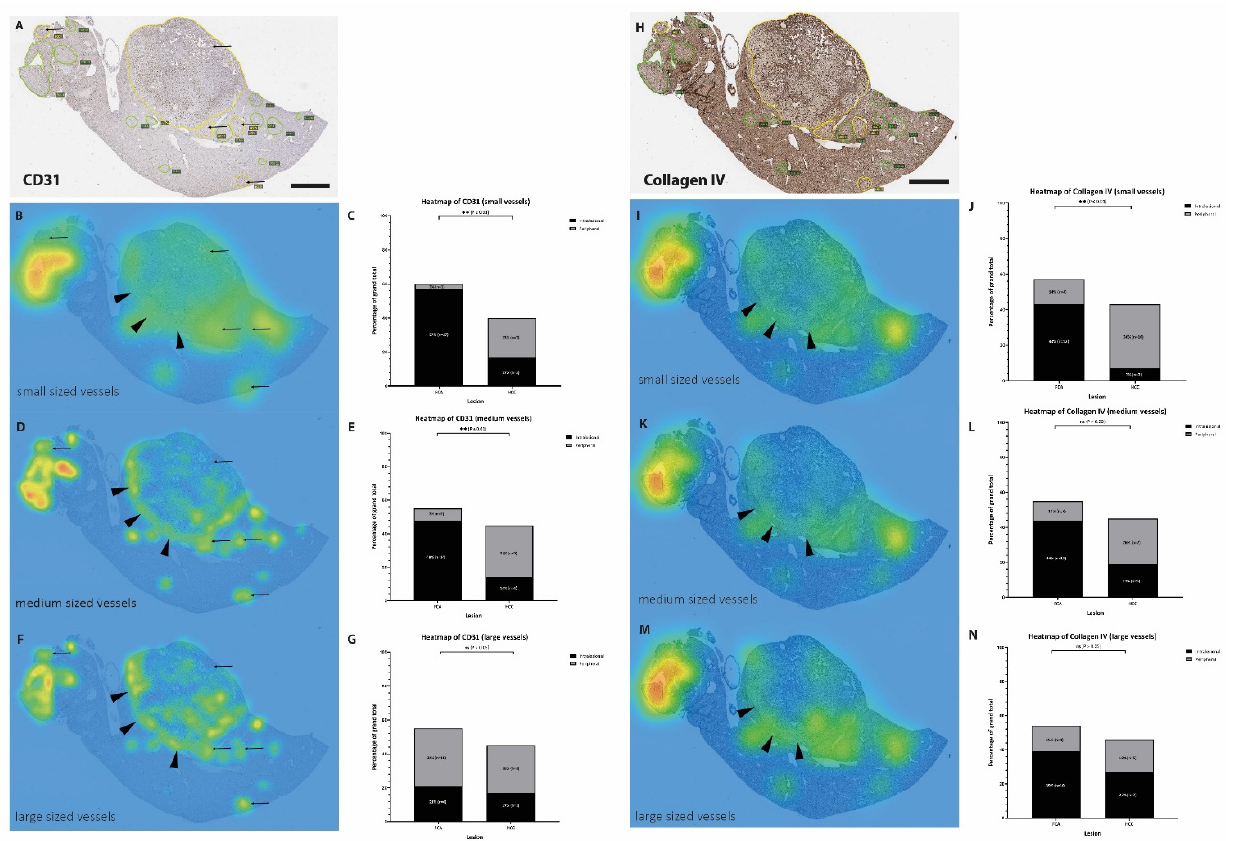
Figure 6. Heatmap of vessel distribution according to size. Annotated FCA (encircled green) and HCC (encircled yellow) in CD31 staining. ( A ) Distribution of the vessel according to their size in small-sized vessels ( B , C ), medium-sized vessels ( D , E ) and large-sized vessels ( F , G ) show a predominant location of small- and medium-sized vessels in the center (intralesional) of FCA, whereas the small- and medium-sized vessels in HCC mostly located at the periphery of HCC (arrowheads). In Collagen IV ( H ) small vessels located in the center (intralesional) of FCA but at the periphery of HCC, with shift towards the periphery in medium- and large-sized vessels ( I – N ). Color coding of heatmap: Green color indicates lowest density, yellow color indicates medium density and red color indicates highest density. Scale bar ( A , B ): 2 mm (magnification 1×). p -values: Not statistically significant (ns) p value > 0.05; for statistical significance, accepted p value ≤ 0.05. ** p value ≤ 0.01, N = number of hotspots identified in each slide and lesion for further in-depth analysis.